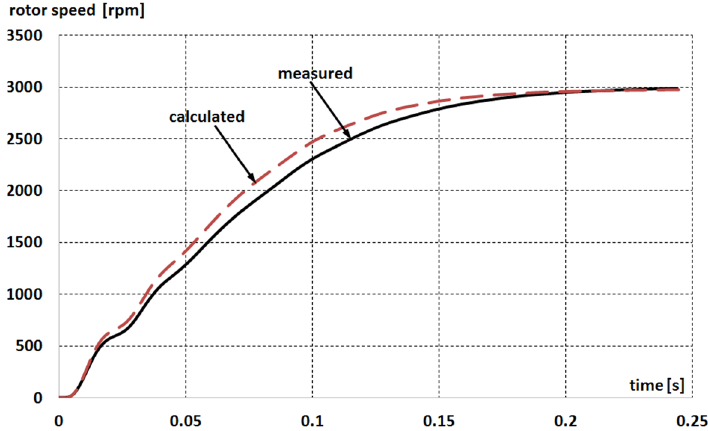
Figure 6. Measured and calculated time waveforms of the instantaneous value of the rotational speed of the motor direct motor starting, when supplied from the mains with a voltage of 50 Hz, for the motor without additional inertial mass ( Js = 0.00009 kg m 2 ).